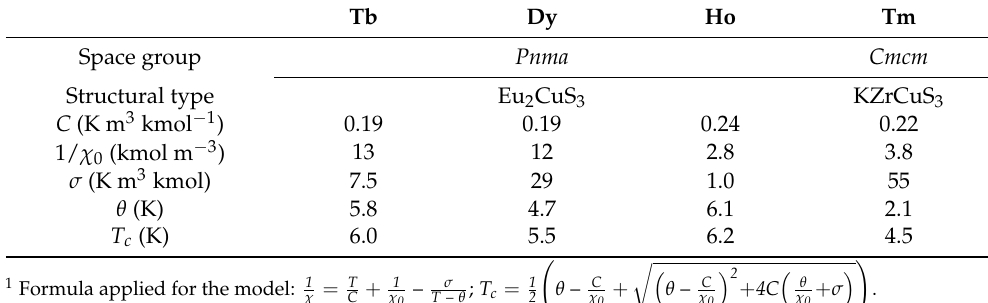
Table 4. Calculation model parameters for ferrimagnetic EuLnCuSe 3 (Ln = Tb, Dy, Ho, Tm) 1 . Tb Dy Ho Tm Space group Pnma Cmcm Structural type Eu 2 CuS 3 KZrCuS